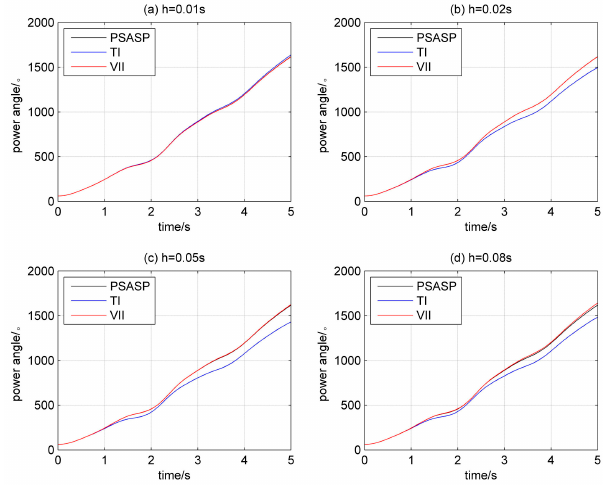
Figure 5. Power angle using different step sizes in case A.